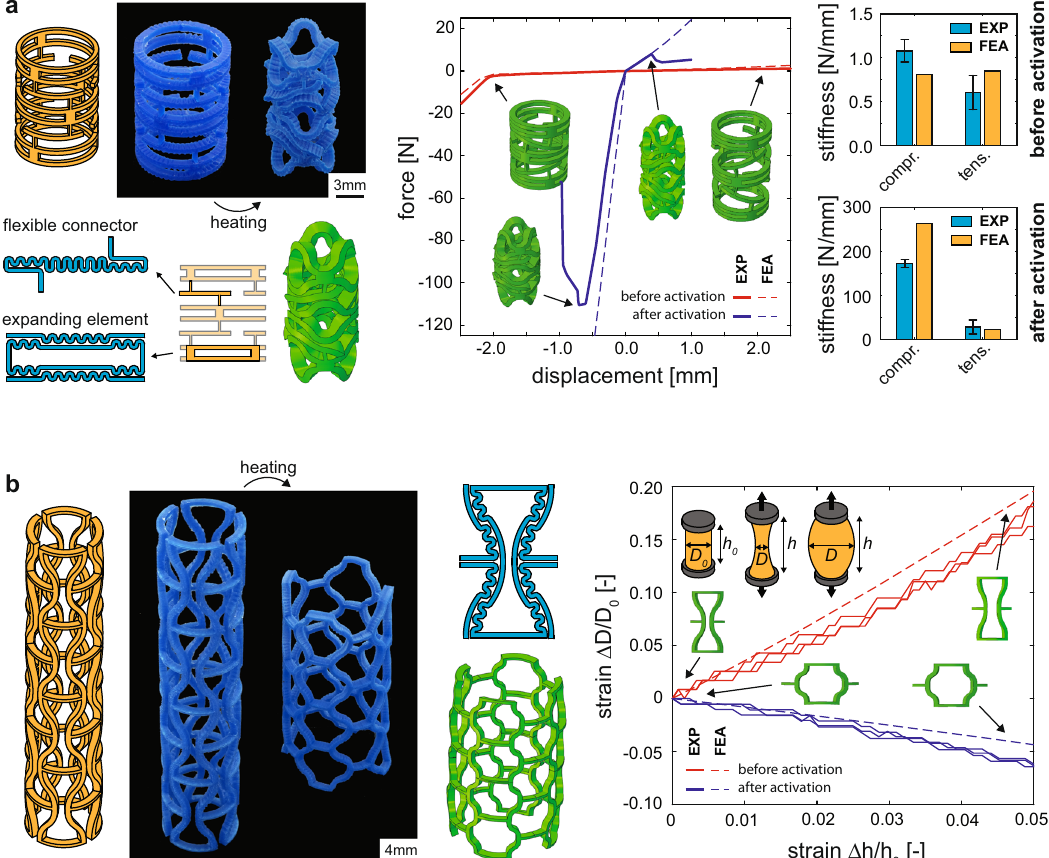
Fig. 3 Switching of mechanical properties. a Shape-shifting structures that switch their mechanical behavior from highly compliant to semi-rigid upon activation. The error bars represent the standard deviation ( n = 3 per group). b The switching of the Poisson ’ s ratio of a 4D printed specimen made using re- entrant unit cells. Upon activation, the specimen switches its mechanical behavior from conventional (i.e., a positive value of the Poisson ’ s ratio) to auxetic (i.e., a negative value of the Poisson ’ s ratio). In all cases, experimental and computational results are presented side by side. See Supplementary Video